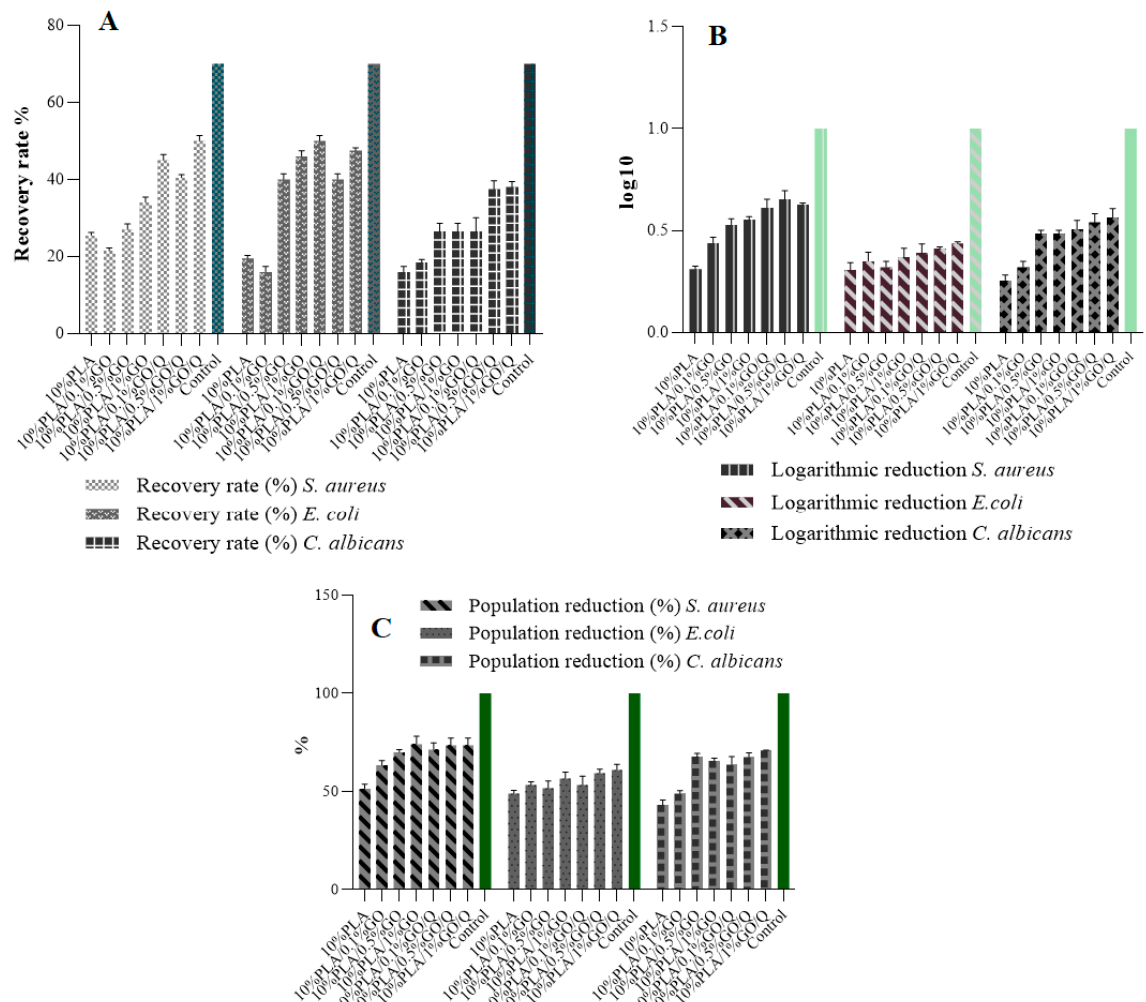
Figure 8. Logarithmic reduction ( A ), population reduction ( B ), and recovery rate ( C ) of S. aureus, E. coli and C. albicans by 10%PLA, 10%PLA/0.1%GO, 10%PLA/0.5%GO, 10%PLA/1%GO, 10%PLA/0.1%GO/Q, 10%PLA/0.5%GO/Q, 10%PLA/1%GO/Q